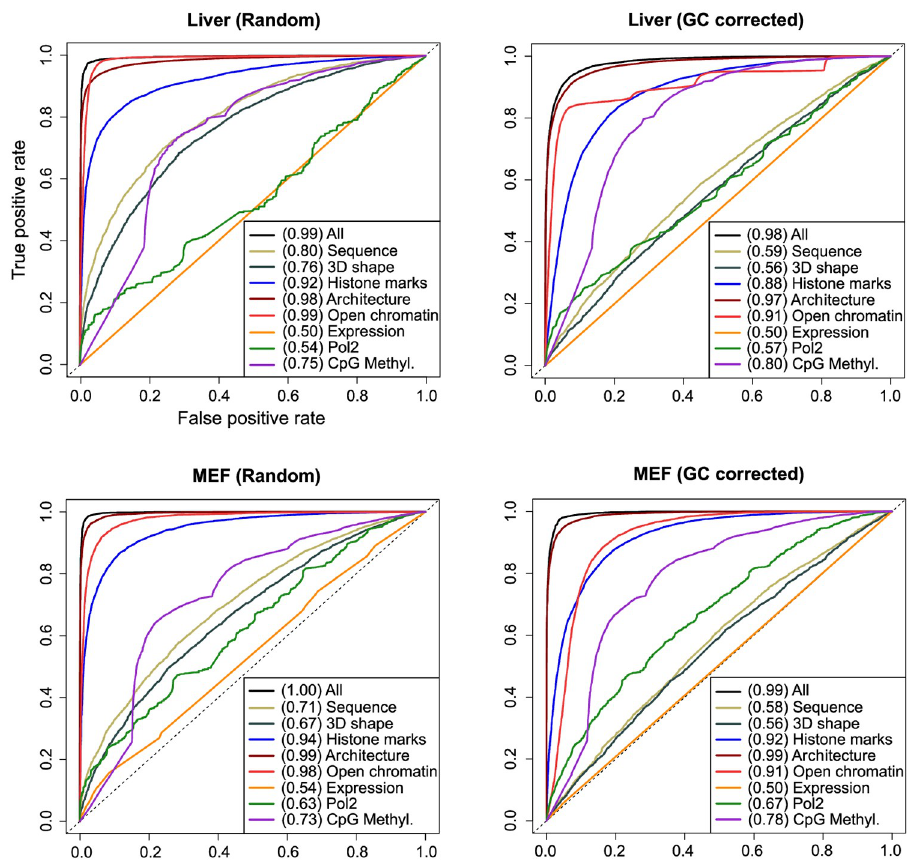
Fig 3. Chromatin features predict TOP2B binding. ROC curves and AUC values for Support Vector Machine models trained on the indicated sets of features (for Naive Bayes models, see S4 Fig).